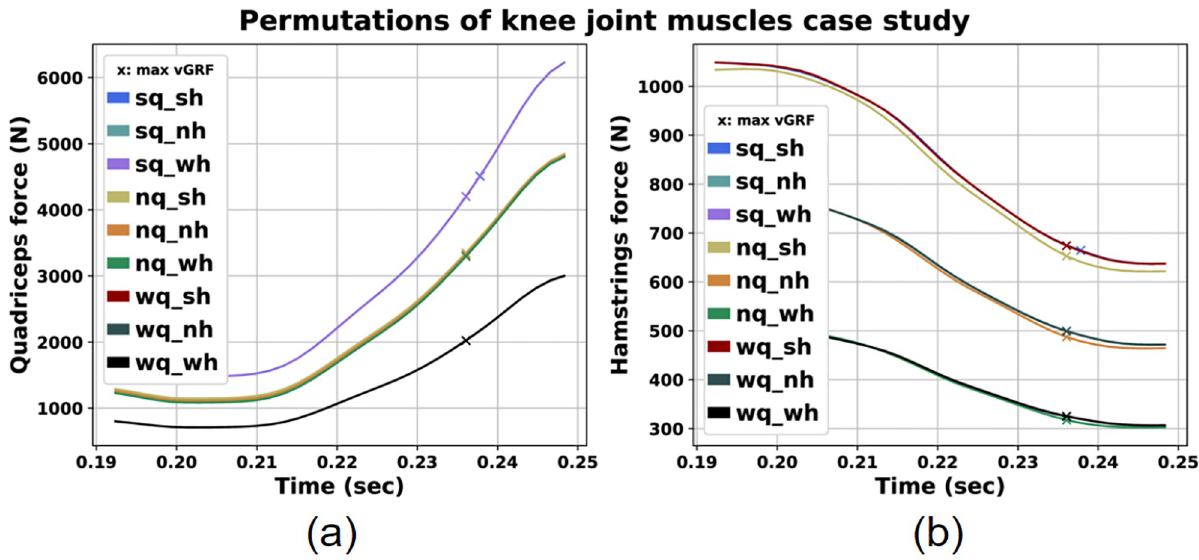
Table 9. The results for the muscle forces, vGRF and AF are presented in Figs 8 and 9, respec- tively. The values of these parameters at peak vGRF time instance are presented in Table 10. We can observe that variation of the maximum isometric force for these two muscle groups affects all simulation results. As illustrated in Fig 8, the scenarios with strong hamstrings resulted in greater hamstrings force. The same holds true for the cases with strong quadriceps. Moreover concernig GRF, we detect lower vGRF peaks for the scenarios with strong quad- ricpes ( sq _ sh , sq _ nh , sq _ wh ), where the lowest peak corresponds to the scenario with both strong hamstrings and quadriceps (Fig 9). Regarding AF, we observe lower values at peak vGRF time instance for the scenarios with weak quadriceps regardless of hamstrings force variation. exhibit the lower vGRF, but also the greatest AF at peak vGRF time instance compared to